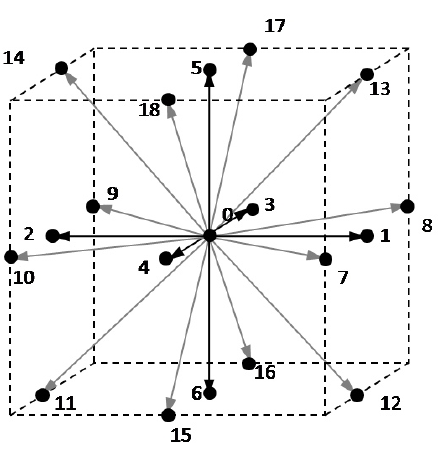
Figure 1. D3Q19 sub-lattice LBM, where vectors indicate α = 1, . . . ,18 directions (and length) for a particle to move on the